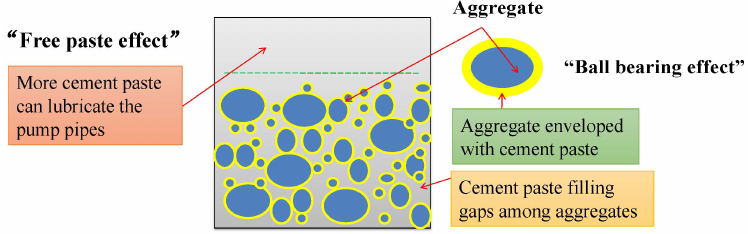
Figure 22. Free paste effect and ball bearing effect in fresh concrete